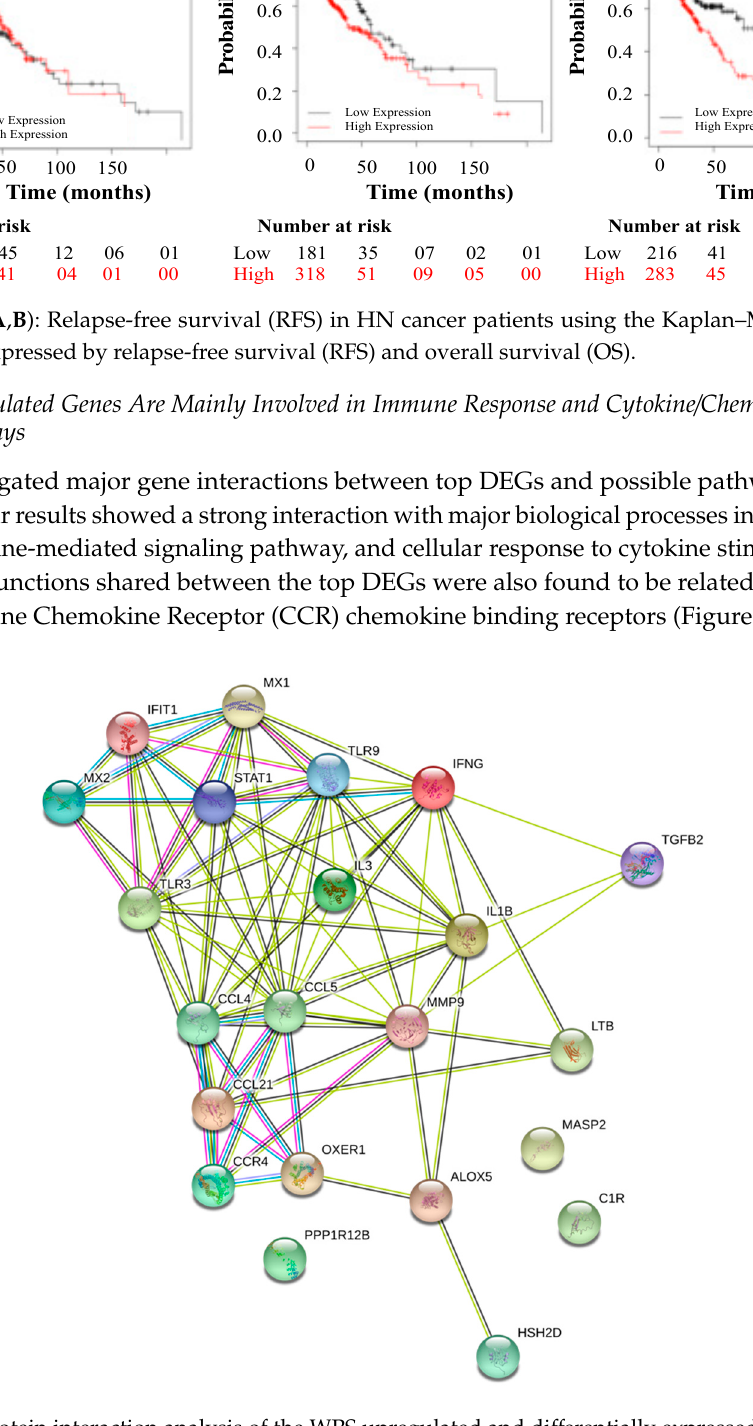
Figure 4. Protein interaction analysis of the WPS upregulated and differentially expressed genes using the Search Tool for the Retrieval of Interacting Genes (STRING v9.1). Enriched biological process and molecular functions of those proteins are included.